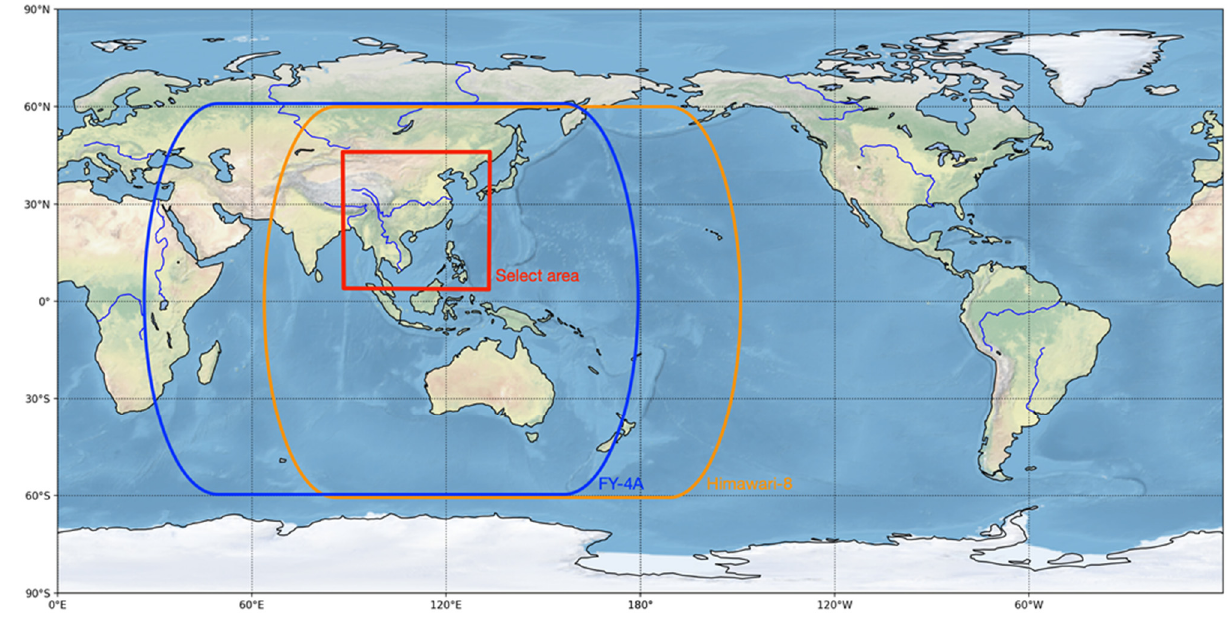
Figure 5. Observation areas of FY-4A and Himawari-8 satellites and experimentally selected areas. Finally, the visible channel data are optically corrected. The reflectance observed by the visible channel of the satellite is affected by solar radiation. It needs to be optically corrected using the cosine of the solar zenith angle to ensure that the radiation level in the direct sunlight region is consistent with the dark side. The data preprocessing flow is shown in Figure 6.